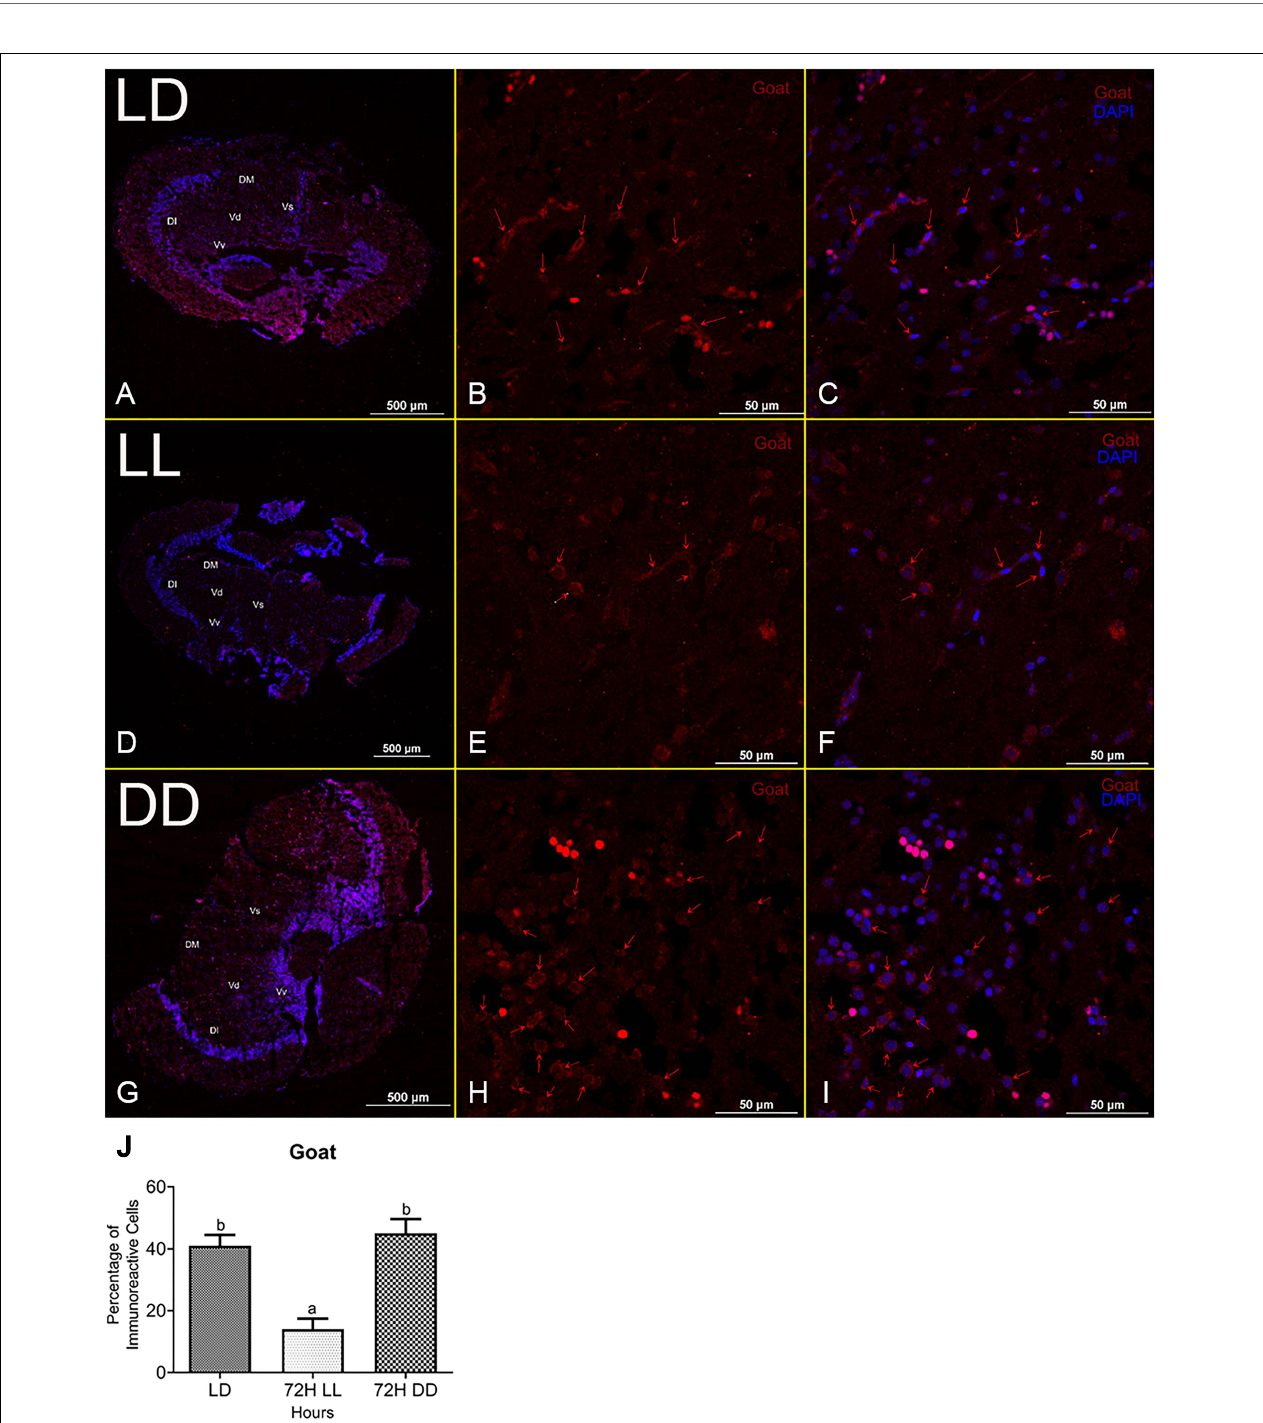
FIGURE 5 | Localization and characterization of Goat in zebrafish brain under different photic conditions (LD, LL, and DD). The figure shows Goat immunoreactivity cells in LD (B) , LL (E) , and DD (H) in the telencephalon region of the brain in zebrafish. Immunohistochemical localization shows Goat immunoreactive cells (red arrow) in the dorsomedial, dorsolateral, and ventromedial zone of the telencephalon in the brain. The whole section of the brain through the telencephalic region (A,D,G) , Goat-positive cells (red) (B,E,H) , and merge imaged with nuclear stain DAPI (C,F,I) . Relative abundance of Goat immunopositive cells in the brain under different photic conditions. The relative quantification values in the graph are shown as the mean ± SEM ( n = 5). Different letters indicate significant differences evaluated by one-way ANOVA [ F (2,6) = 18.816, p = 0.003] followed by post-hoc Tukey’s test ( p < 0.05) (J) . For the percentage calculation method, please consult the section “Materials and Methods.” Representative images were taken from multiple sections of five separate zebrafish brain in each experimental condition (Vs, supracommissural nucleus; Vd, dorsal nucleus; Vv, ventral nucleus of ventromedial telencephalon).